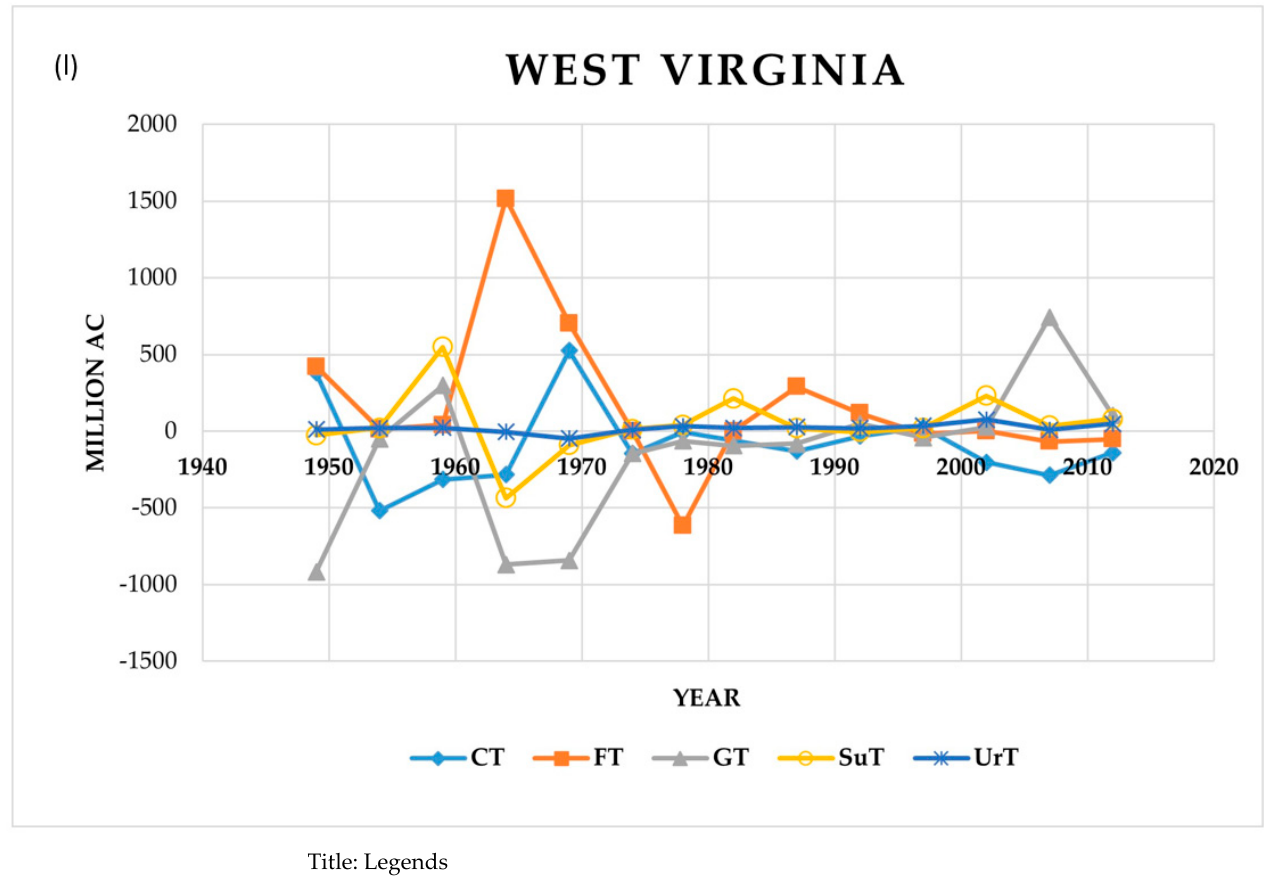
Figure 2. Land type analysis of twelve states for five land types in the SEUS ( a – l